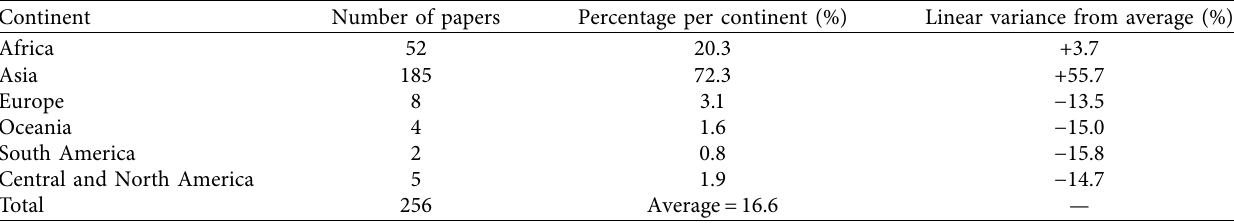
Table 13: Distribution percentages of population papers obtained in literature search.